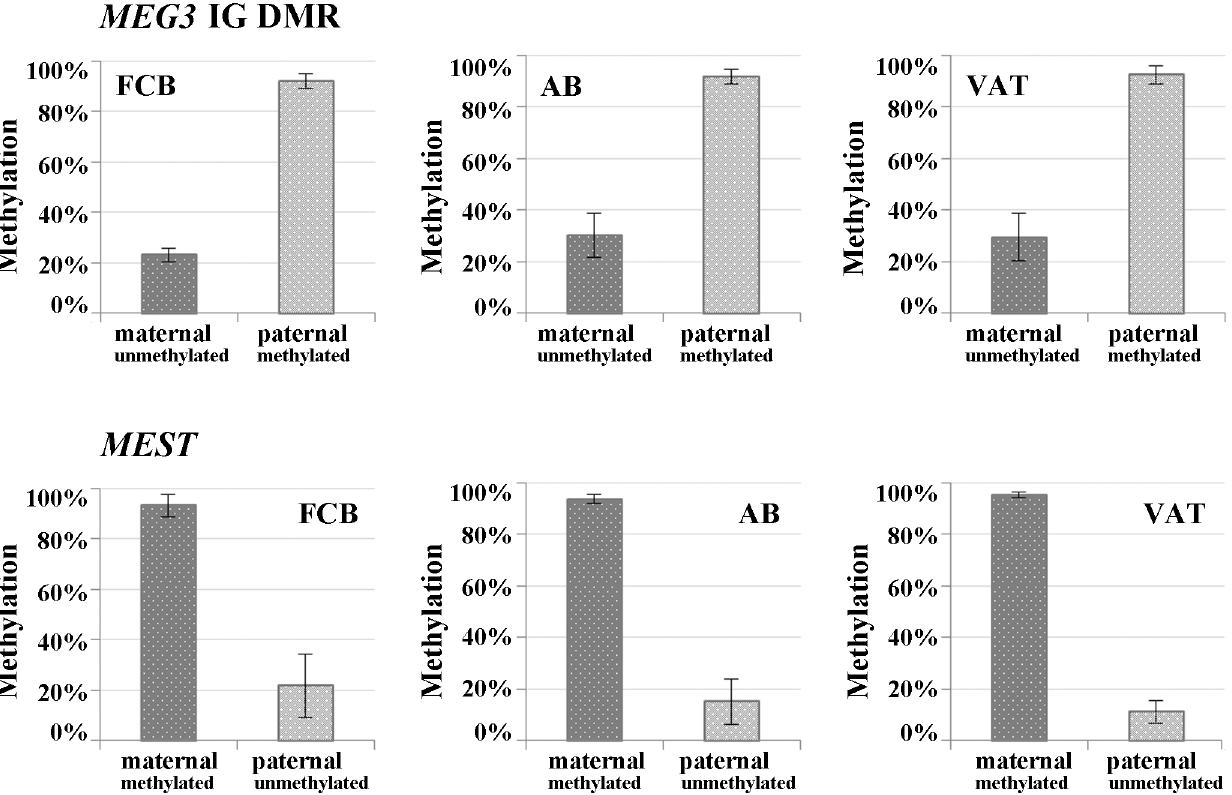
Fig 1. Parental allele-specific methylation of the MEG3 IG DMR and the MEST promoter. Mean methylation levels and standarddeviations of the paternalvs. maternal alleleswere determinedby DBS with the Roche GSJunior in FCB, AB, and VAT. For both genes, the non-imprinted allele, which is expectedto be completelyunmethylated, showedan aberrantlyhigh methylationin all analyzedtissues, whereasthe imprinted alleleshowedthe expected(90–100%)methylation.